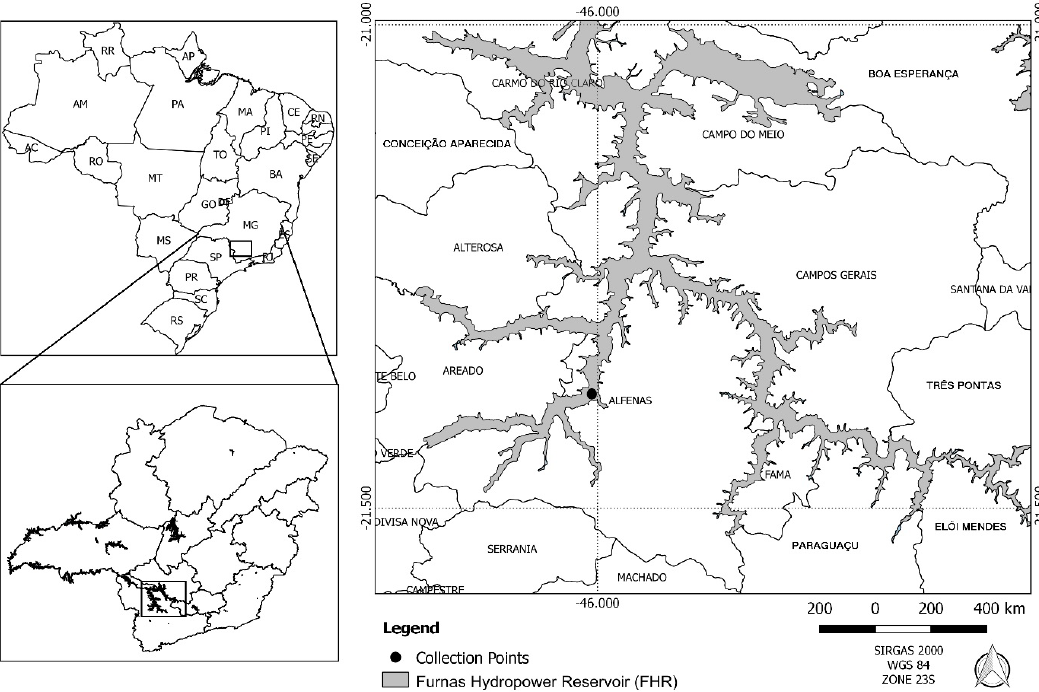
Figure 1. Localization of sampling station in Sapucaí River compartment of Furnas Reservoir, Minas Gerais State,